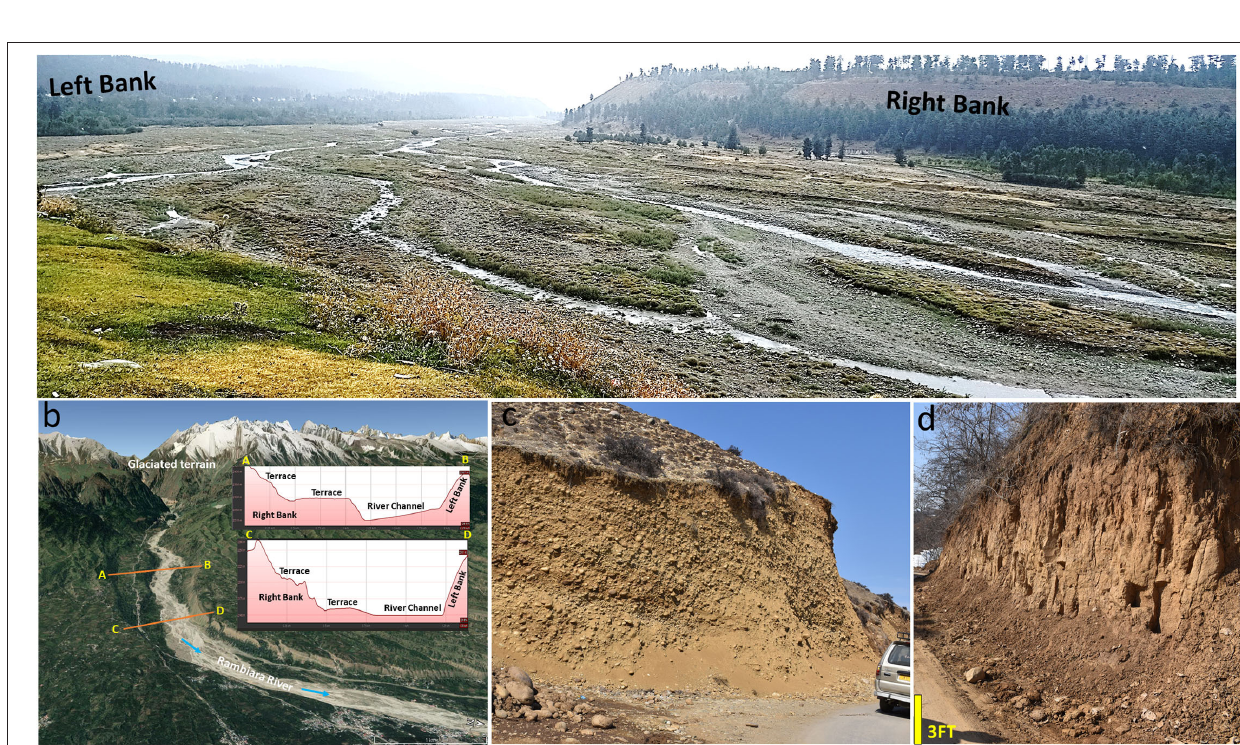
FIGURE 6 | (a) showing the braided pattern of the Rambiara river near Shopian town, (b) the Google Earth image showing the unpaired terraces near the Hirpur Village, (c) river terrace and (d) the loess deposits blanketing the river terraces near Shopian town.